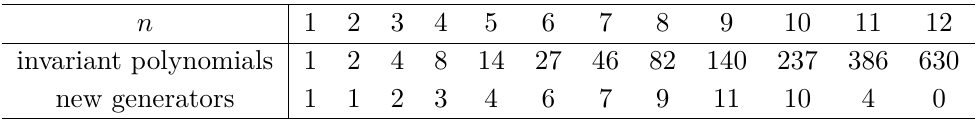
Table 1. Number of linearly independent invariant polynomials, and number of generators of degree n at genus g = 2